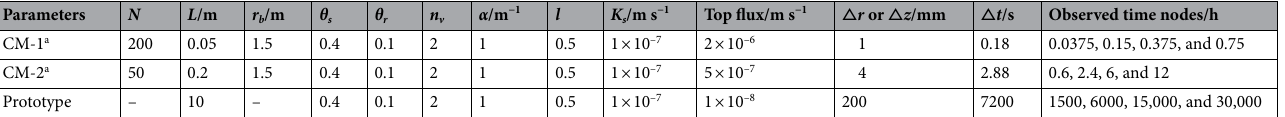
Table 3. Parameters used in the centrifugal model and the prototype simulated by Hydrous 1-D software package. a CM represents centrifugal